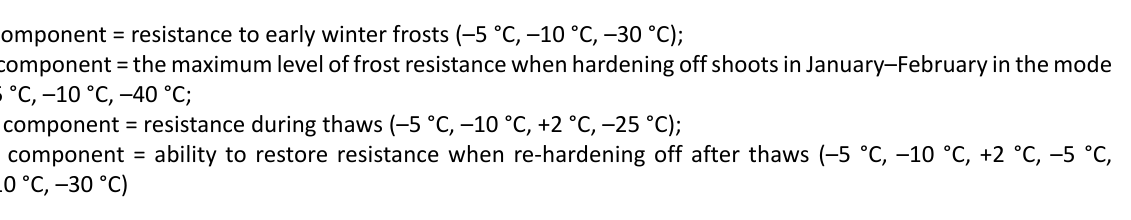
Table 2. Meteorological conditions of the growing period from 2009 to 2018 (May–September) (Data from the VNIISPK weather station) Average temperature Deviation from the Years (May – September) average annual air °C temperature (+, –) Average for 15.4 many years